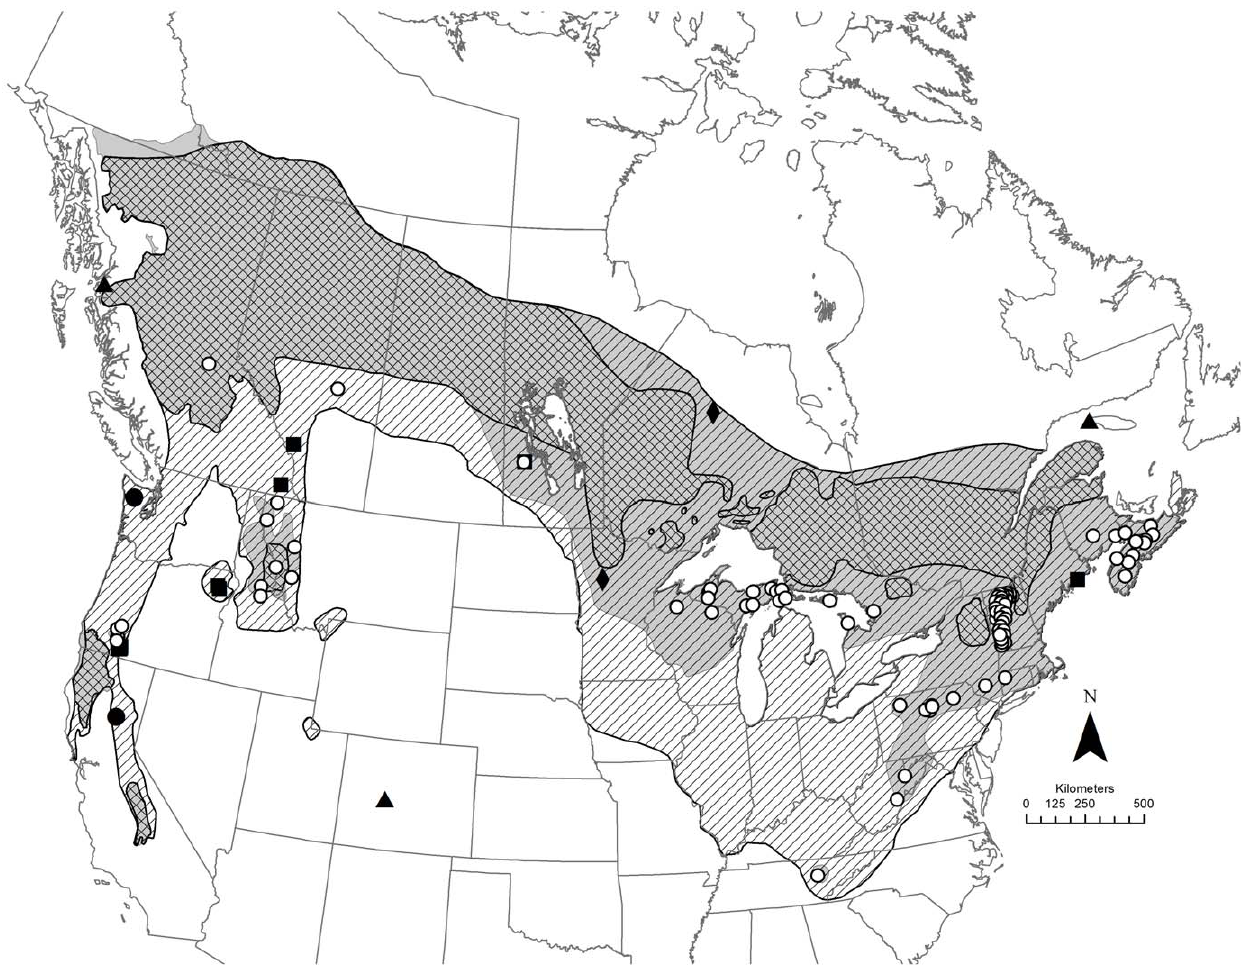
Figure 6. Locations of translocations in relation to the fisher’s historical, most-contracted and current range. The historical fisher range occurred prior to European settlement (diagonal hatching), but was reduced to the range at its most contracted state (cross hatching; 43% of the historical range) before expanding to the current range (shaded; 68% of the historical range). White circles represent successful reintroductions or augmentations, black squares represent failed reintroductions, black diamonds represent reintroductions with unknown outcomes, black circles represent ongoing reintroductions and black triangles represent introductions.